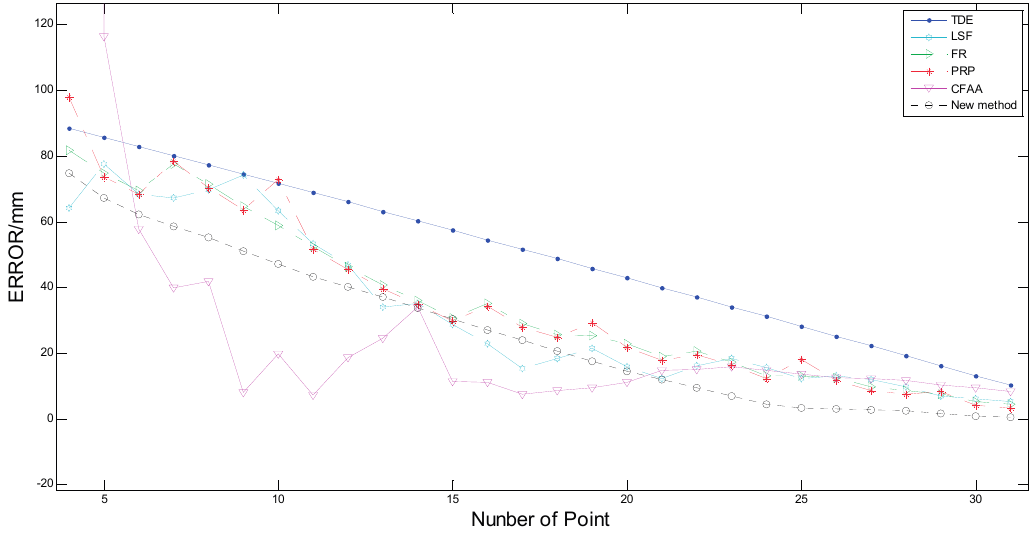
Figure 12. The estimation error decreased with increasing number of point hitting the tree, which was associated with the size of the